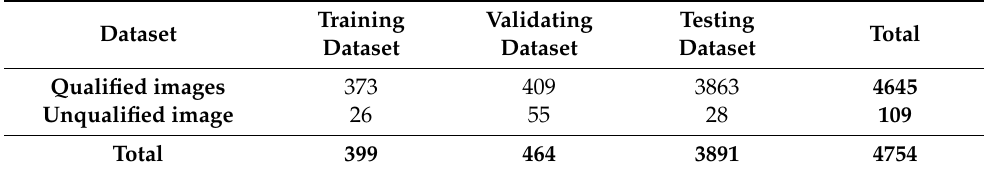
Table 1. Description of experimental datasets.